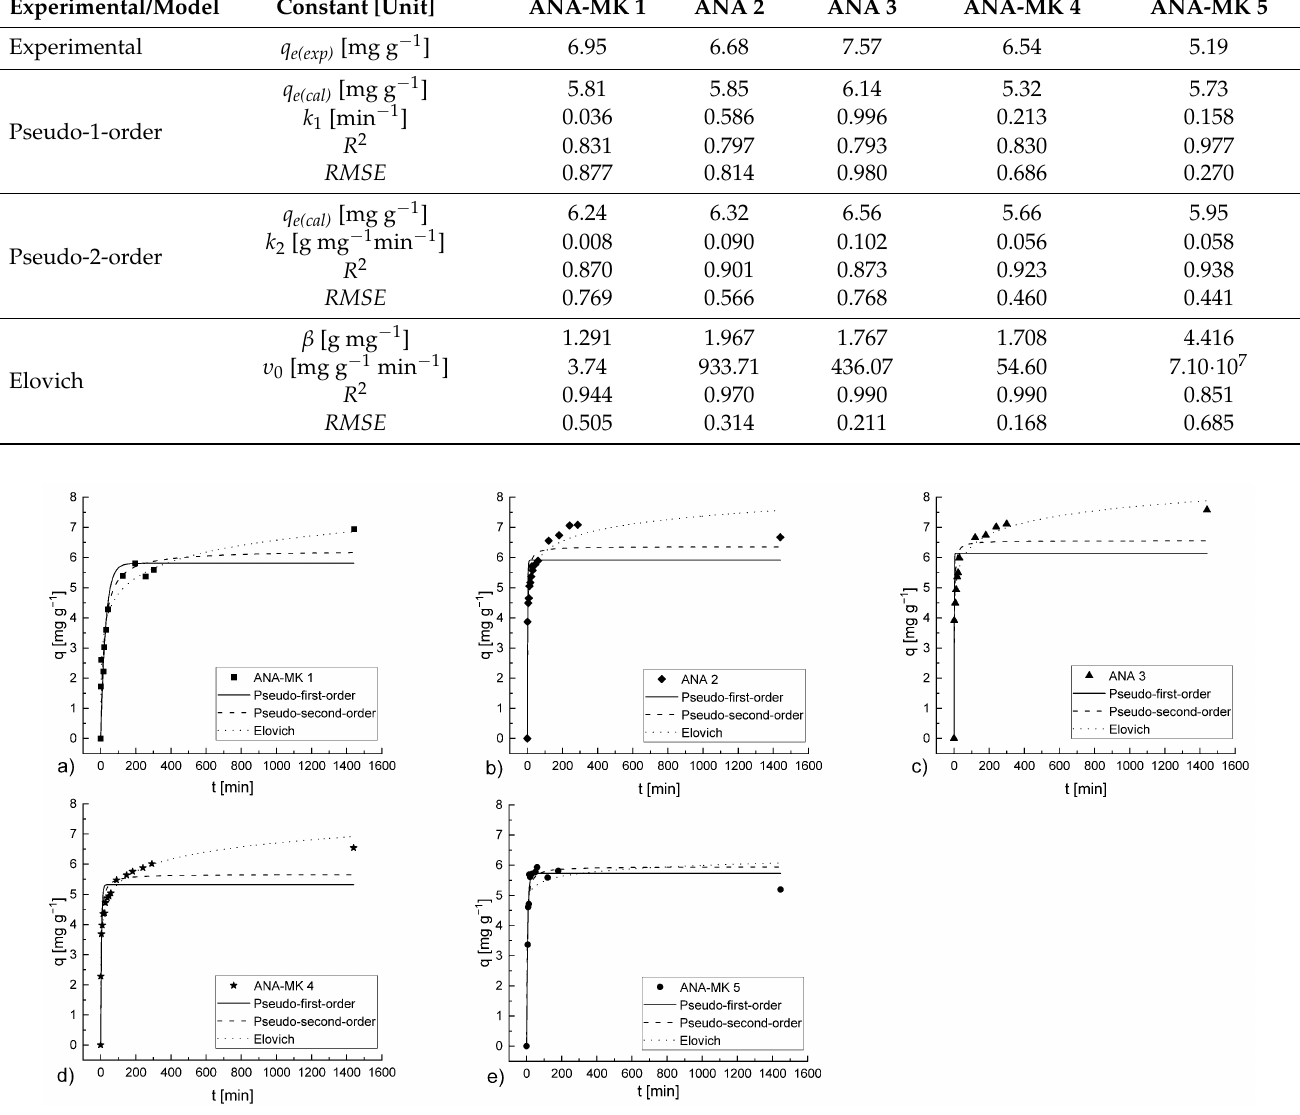
Figure 10. Pseudo-first-order, pseudo-second-order, and Elovich model plots of NH 4 + ion removal using ( a ) ANA-MK 1, ( b ) ANA 2, ( c ) ANA 3, ( d ) ANA-MK 4, and ( e ) ANA-MK 5.